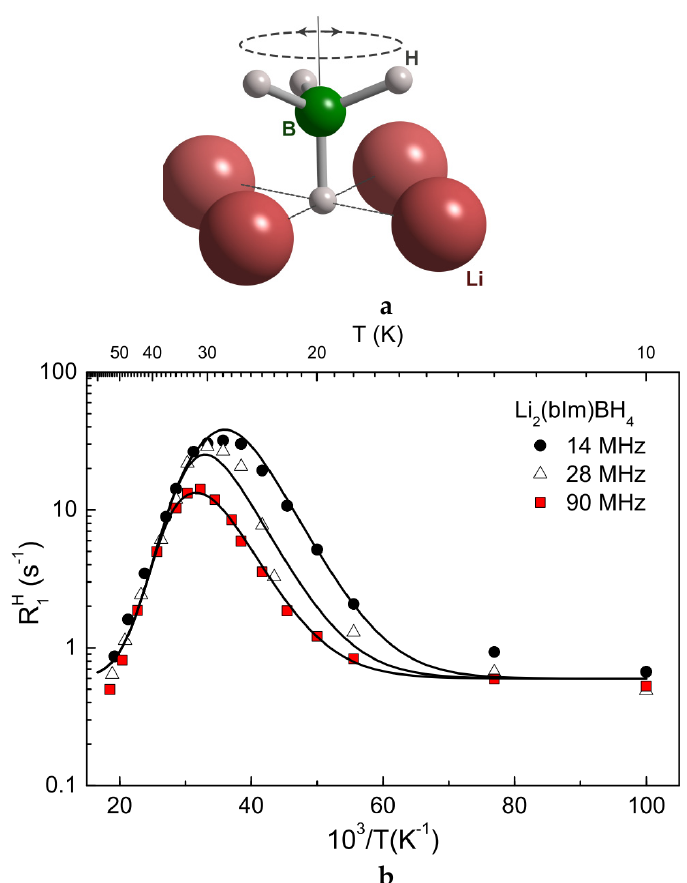
Figure 2. ( a ) Schematic view of the local coordination of each BH 4 − anion in Li 2 (bIm)BH 4 . This coordination allows facile reorientations of three H atoms (as depicted by the dashed ellipse) around the single B-H bond axis [60]. ( b ) Low-temperature proton spin–lattice relaxation rates measured at 14, 28, and 90 MHz as functions of the inverse temperature. Solid lines show the simultaneous fit of the model with rotational tunneling to the data. Reprinted with permission from [60]. Copyright 2019 American Chemical Society.